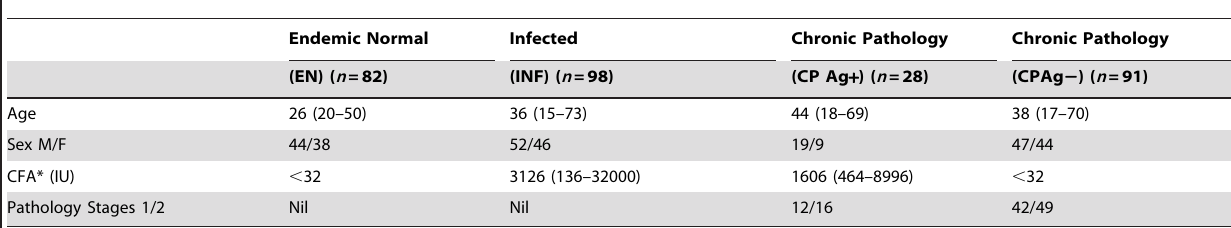
Table 1. Characteristics of the study population.